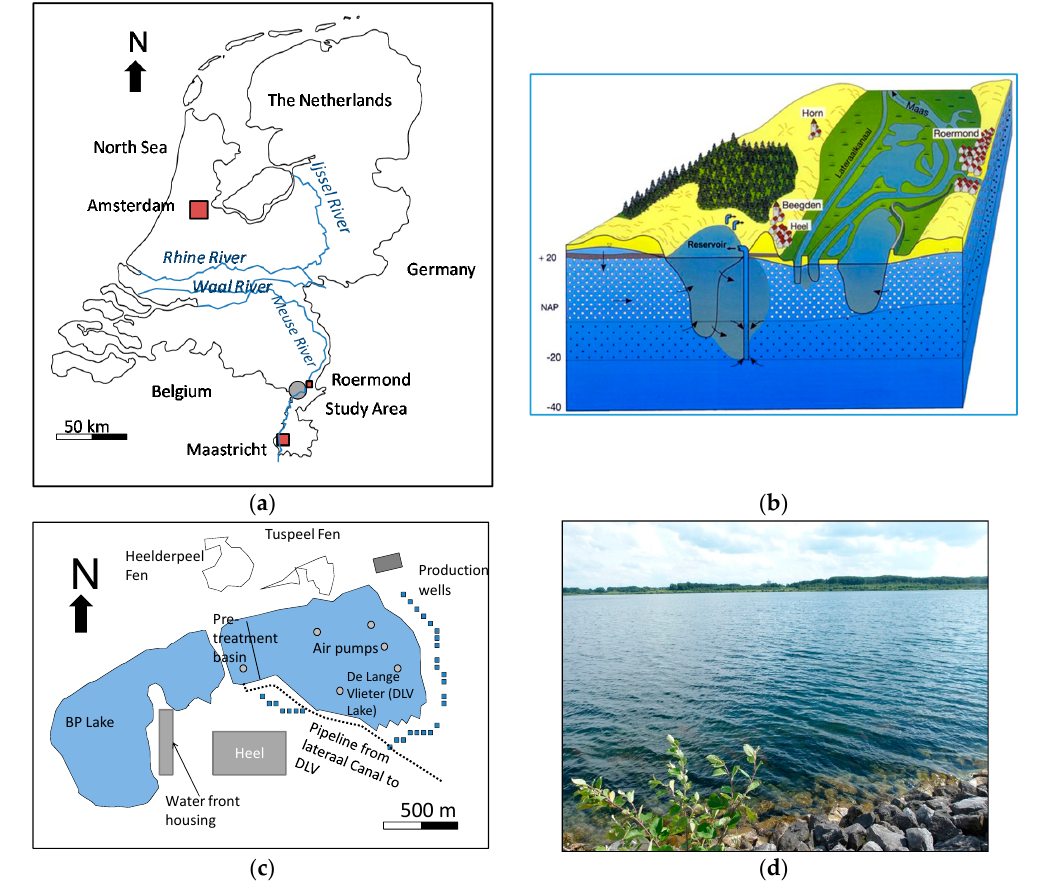
Figure 2. ( a ) Location of study area within the Netherlands; ( b ) 3D artist’s sketch of DLV Lake and Meuse River; ( c ) Map of study area with DLV and BP Lakes, location of air blowers and extraction wells and ( d ) Photograph of DLV Lake.